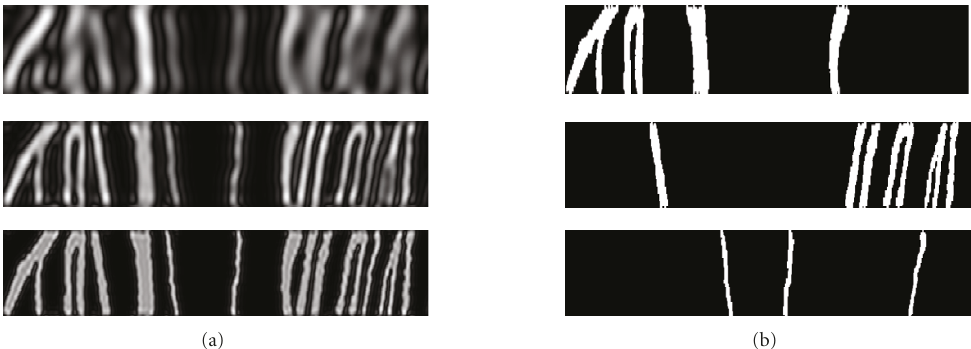
Figure 11: (a) Multiscale analysis of polar image: wavelet approximation coe ffi cients in scale 3 (up), 2 (middle), and 1 (bottom); (b) vessel separation result: large (up), medium (middle), and small (bottom)